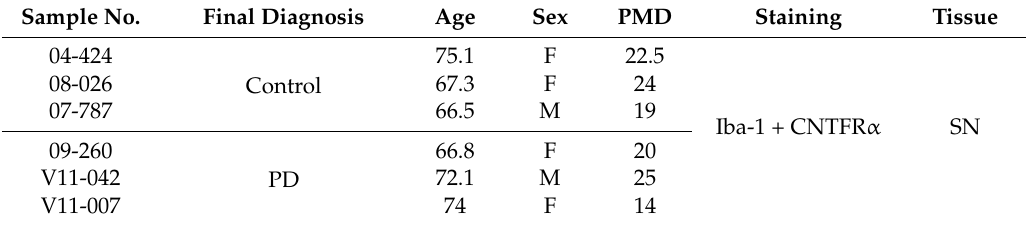
Table 1. Human postmortem tissues used for immunofluorescence in Figure 4D–F. Sample